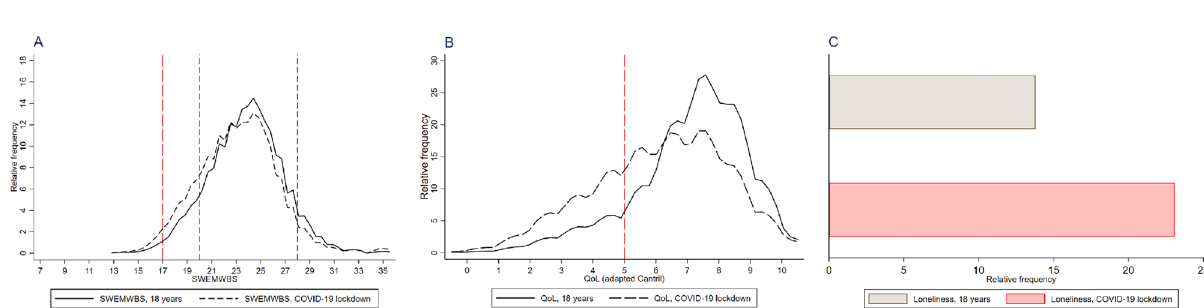
Figure 2. Distribution of baseline and follow-up mental well-being (SWEMWBS) scores, QoL scores, and loneliness (No. = 7445). SWEMWBS Short Warwick-Edinburgh Mental Well-Being Scale, QoL Quality of Life. ( A ) Kernel density plot of the distribution of mental well-being (SWEMWBS) scores: Long dash red reference for probable anxiety/depression 16 , short dash red reference line for indication of possible anxiety/depression, and black short reference line for indication of high mental well-being, ( B ) Kernel density plot of distribution QoLscores: Long dash red reference for cut-off of low QoL 18 , ( C ) Barplot of loneliness. Participants in the tails of SWEMWBS were aggregated in kernel density plots to secure non-identifiability of